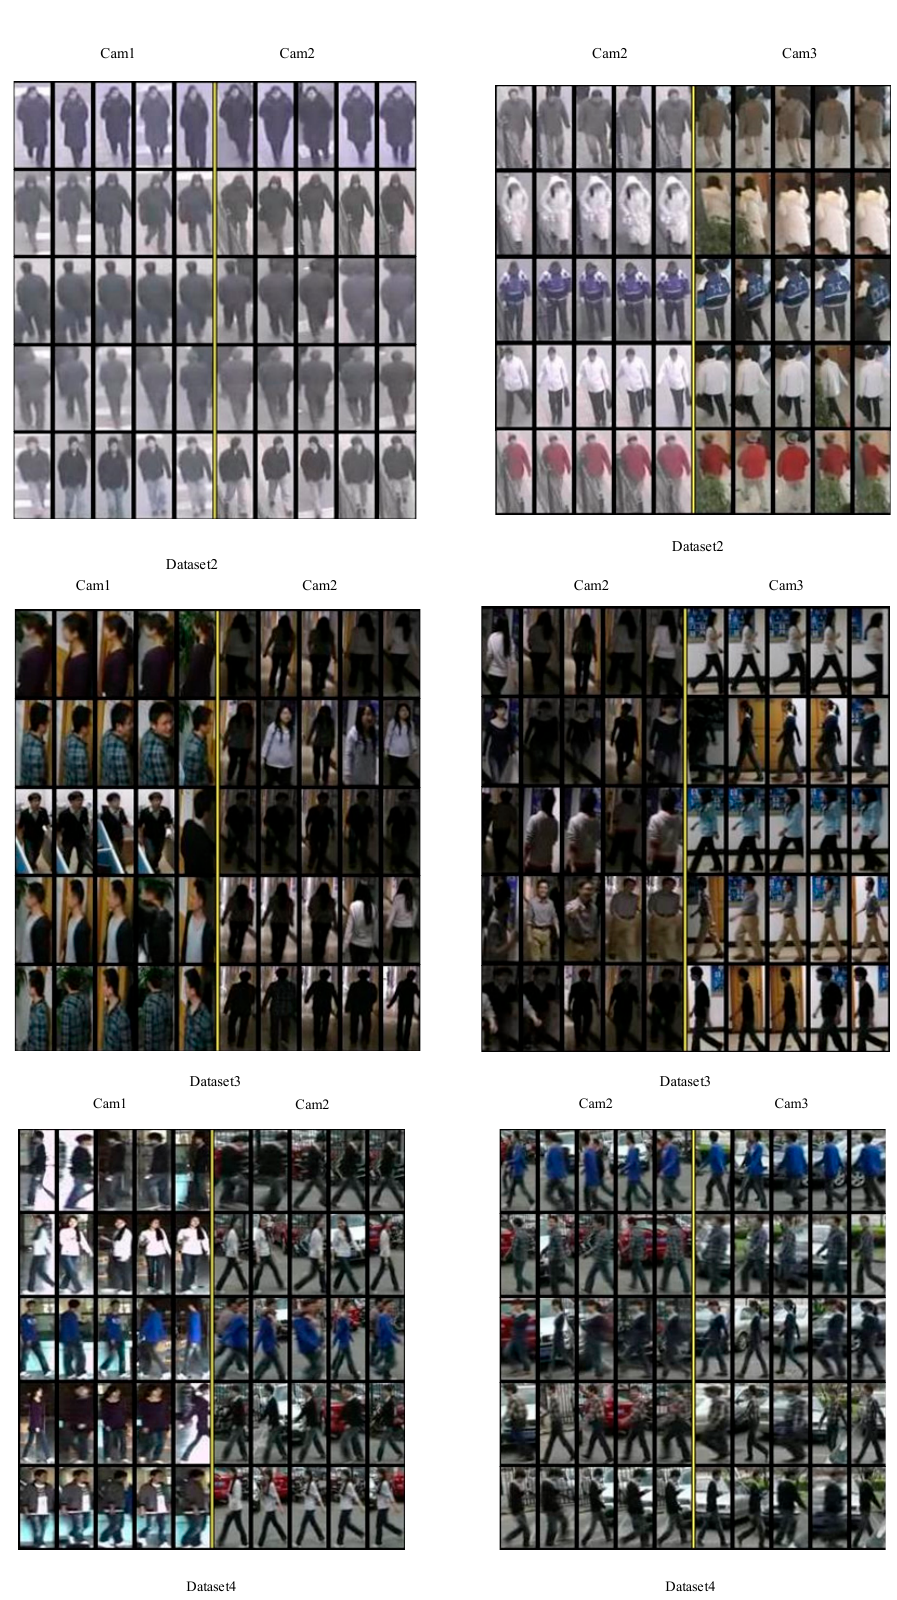
Figure 9. Part of the inter-camera matching results. To quantitively evaluate performance, the statistical results of SPMI and MPSI are displayed in Table 2, and we compare with the results that come from EGTracker [11]. For MPSI, our algorithm